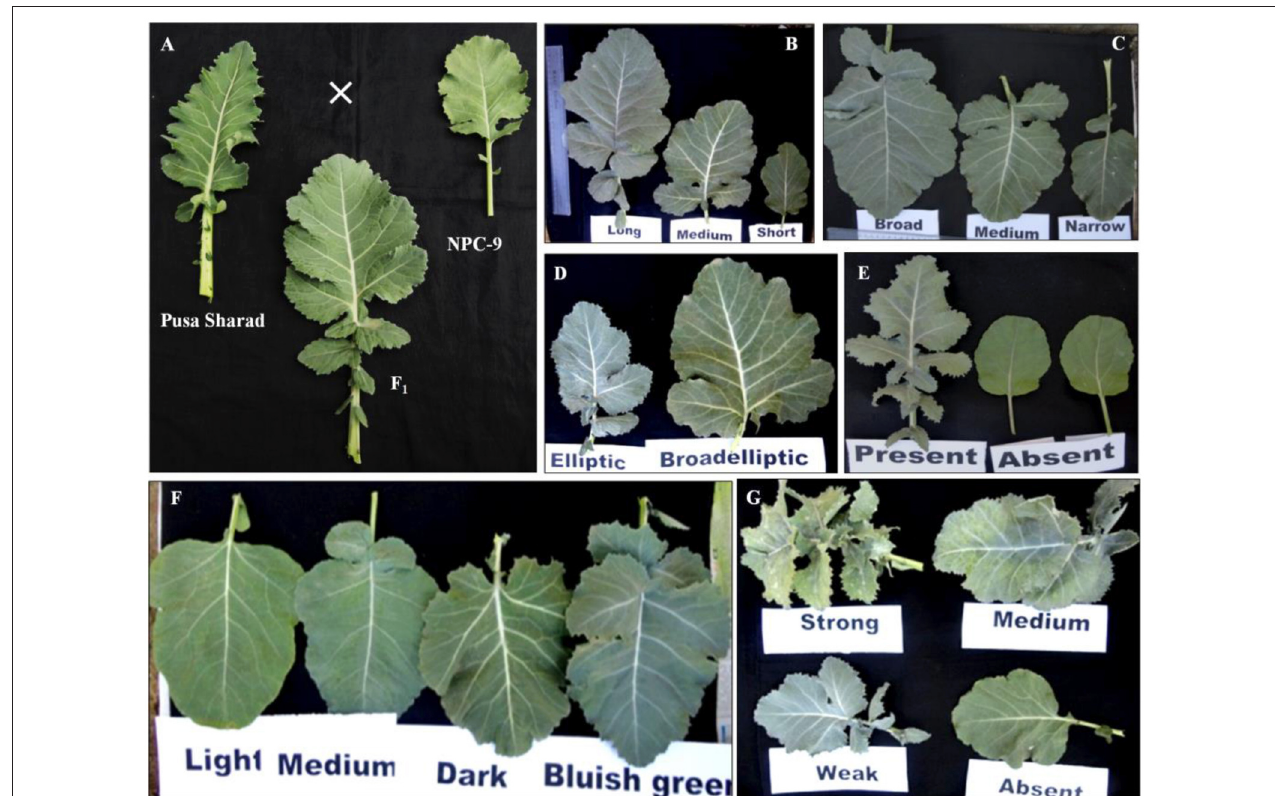
FIGURE 8 | Leaf characteristics and morphology of parental genotypes with BC 1 plants. (A) Cauliflower (Pusa Sharad), B. carinata (NPC-9), Inter-specific (F 1 ) hybrid. (B) Leaf length. (C) Leaf width. (D) Leaf shape. (E) Leaf lobes. (F) Leaf color. (G) Leaf puckering variations in BC 1 .